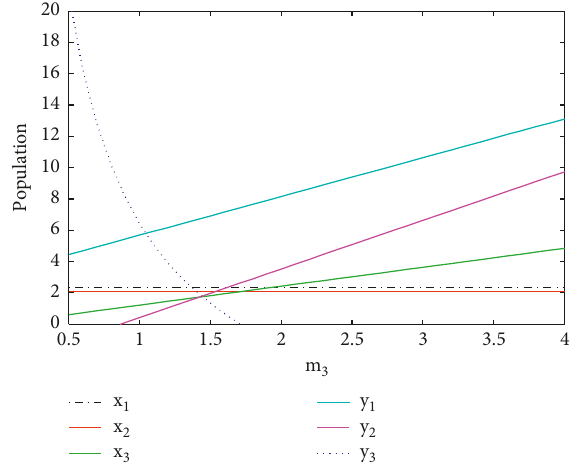
Figure 18: Effect of m